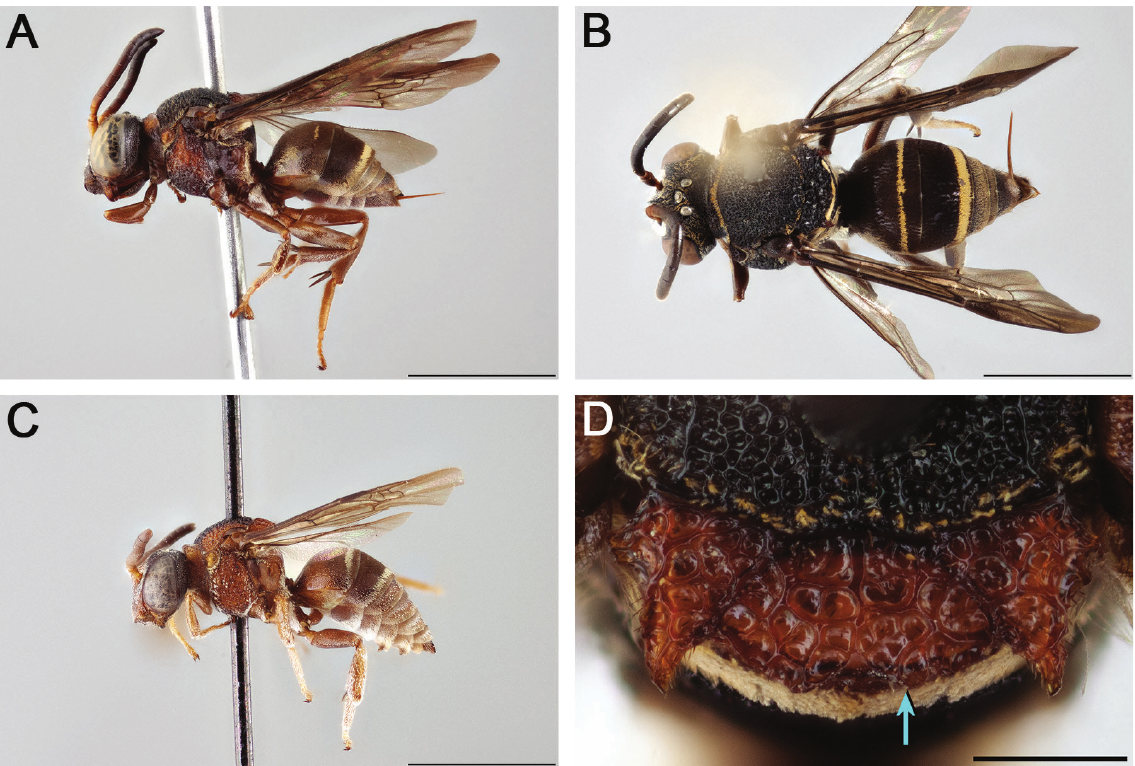
Fig. 6. Epeolus boliviensis Friese, 1908. A . Female, habitus, lateral view. B . Female, habitus, dorsal view. C . Male holotype, habitus, lateral view, ZMB. D . Female axillae and mesoscutellum, dorsal view (blue arrow indicates one of two posteriorly directed tooth-like projections of mesoscutellum). Scale bars: A–C = 3 mm; D = 0.5